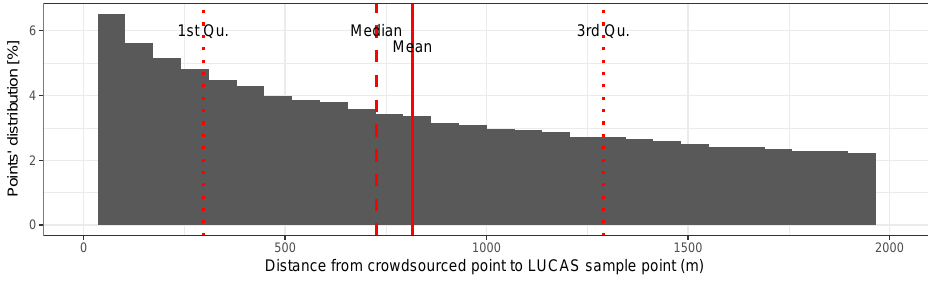
Figure 7. Distribution of the distances between LUCAS points and the locations of the closest crowdsourced image.